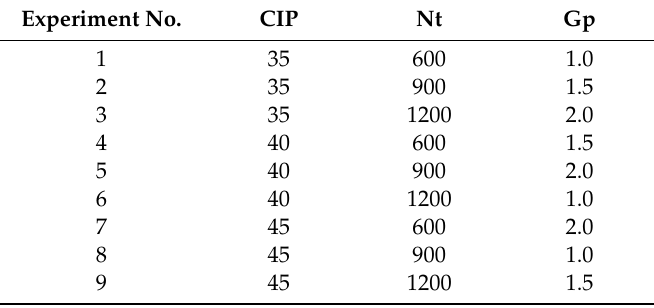
Table 2. Control log of